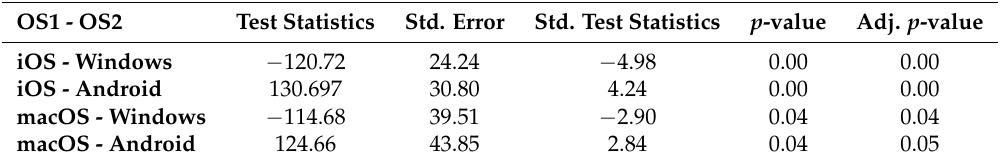
Table 10. Values of the Kruskal-Wallis statistical test and the Bonferroni post-hoc test showing significant differences between the number of failed subjects and the OS used for